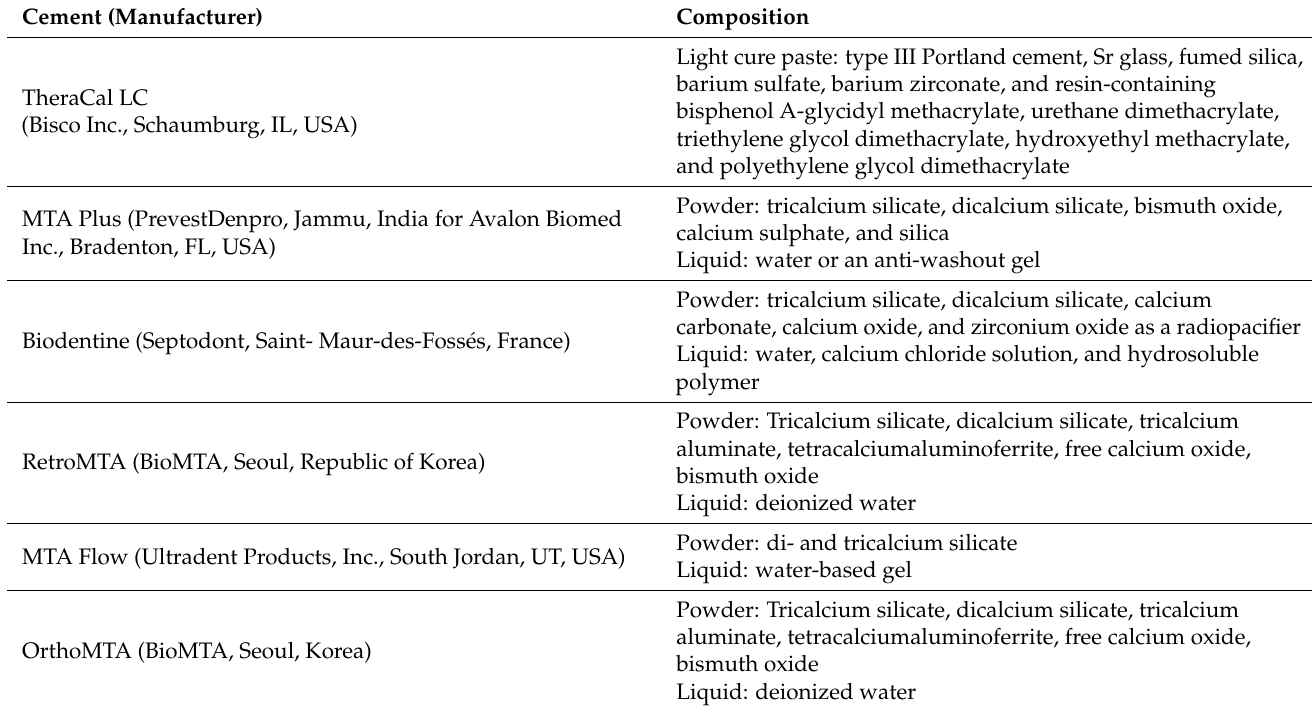
Table 1. Composition of calcium silicate-based materials as provided by